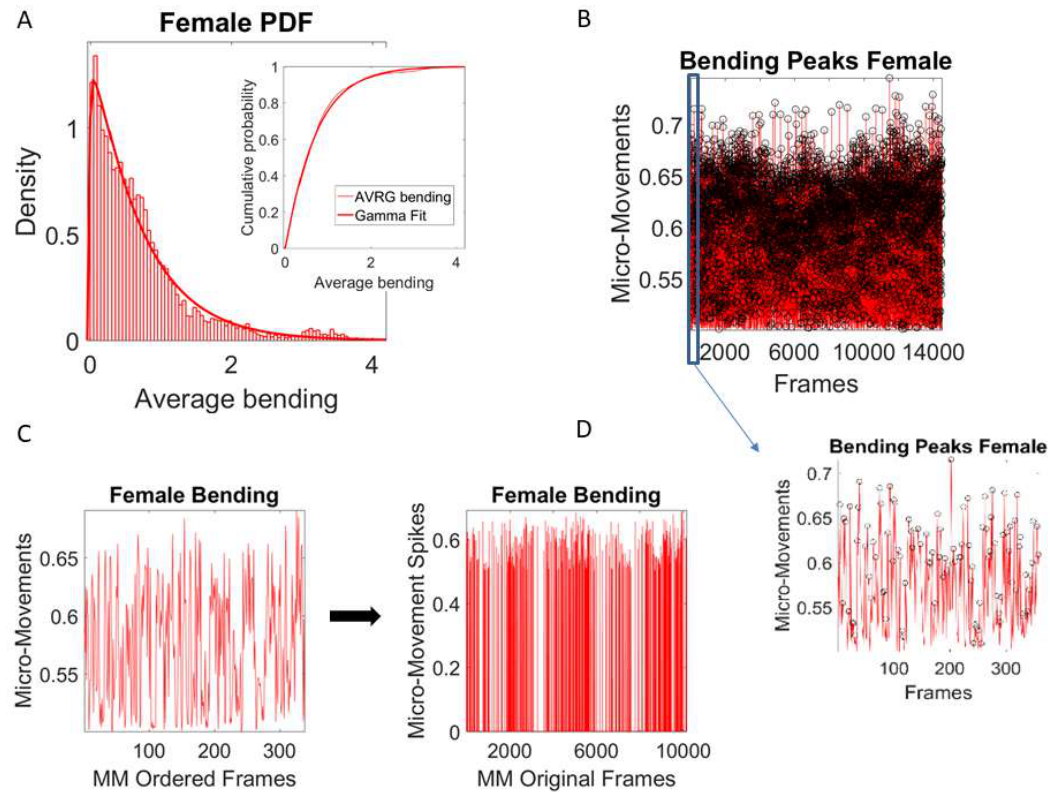
Figure 4. Pipeline of signal processing to obtain the micro-movement spikes of the bending amplitude as input to a Gamma process and cross-coherence analyses. ( A ) Average bending of the peaks from female dancer (one motion LED) obtained from Equation (2) of the main text is Gamma-distributed. Similarly, the peaks of the bending (not shown) are Gamma-distributed. As such, the MM derived from the normalization formula in Equation (2) are also Gamma-distributed and can be modeled by a Gamma process. ( B ) Extraction of MM from full bending profile of a routine, with inset showing the MM spikes corresponding to a segment automatically extracted from speed pauses (see Figure 3B,C). ( C ) Sampled 350 peaks (in the order in which they were acquired) from the motion path curvature generated by one LED (on the female) during a routine registered with 10 K frames are normalized as per Equation (2). They provide the amplitude MM scaled between 0–1 and are then zero-padded to recover the original number of frames in that routine segment. This procedure applied to all LEDs from both dancers then provides equal length MM spike vectors for pairwise cross-coherence analyses across all body parts of the two dancers. ( D ) Full MM spikes across all frames, zero-padded to retain equal number of frames for cross-coherence